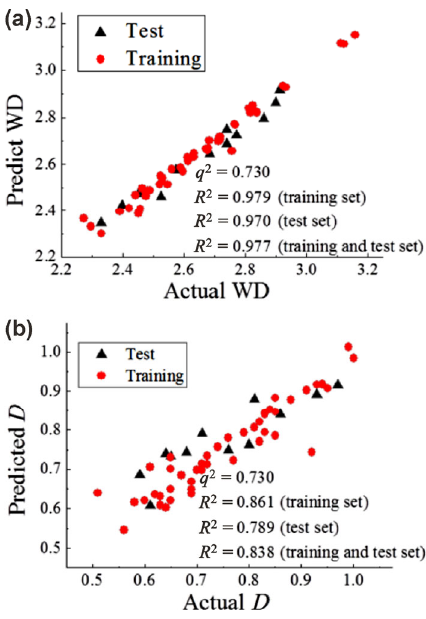
Fig. 4 Plots of the actual versus the predicted values of WD (a) and D (b) obtained by CoMSIA model for the training and the test set of compounds.